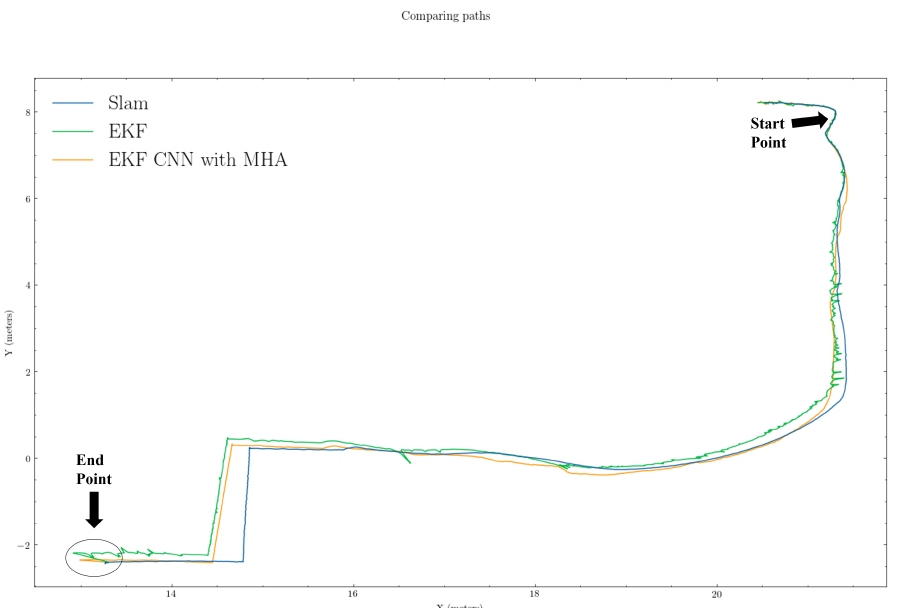
Figure 5. Estimated path comparison results for trajectory 1. Green, orange, and blue lines represent EKF, EKF+CNN with MHA, and ground truths,